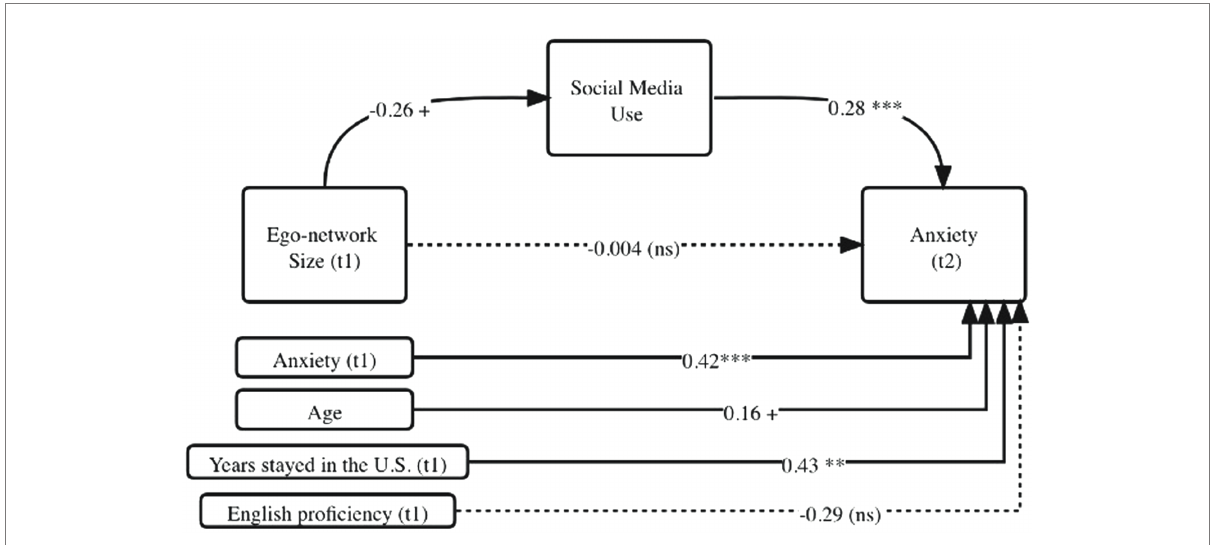
FIGURE 1 Model test results: personal network size, social media use and anxiety (Study 1). + p < .0.10, ** p < 0.05, *** p < 0.01. Coefficients are